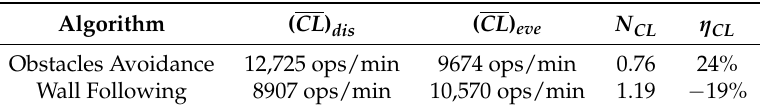
Table 6. Computational load